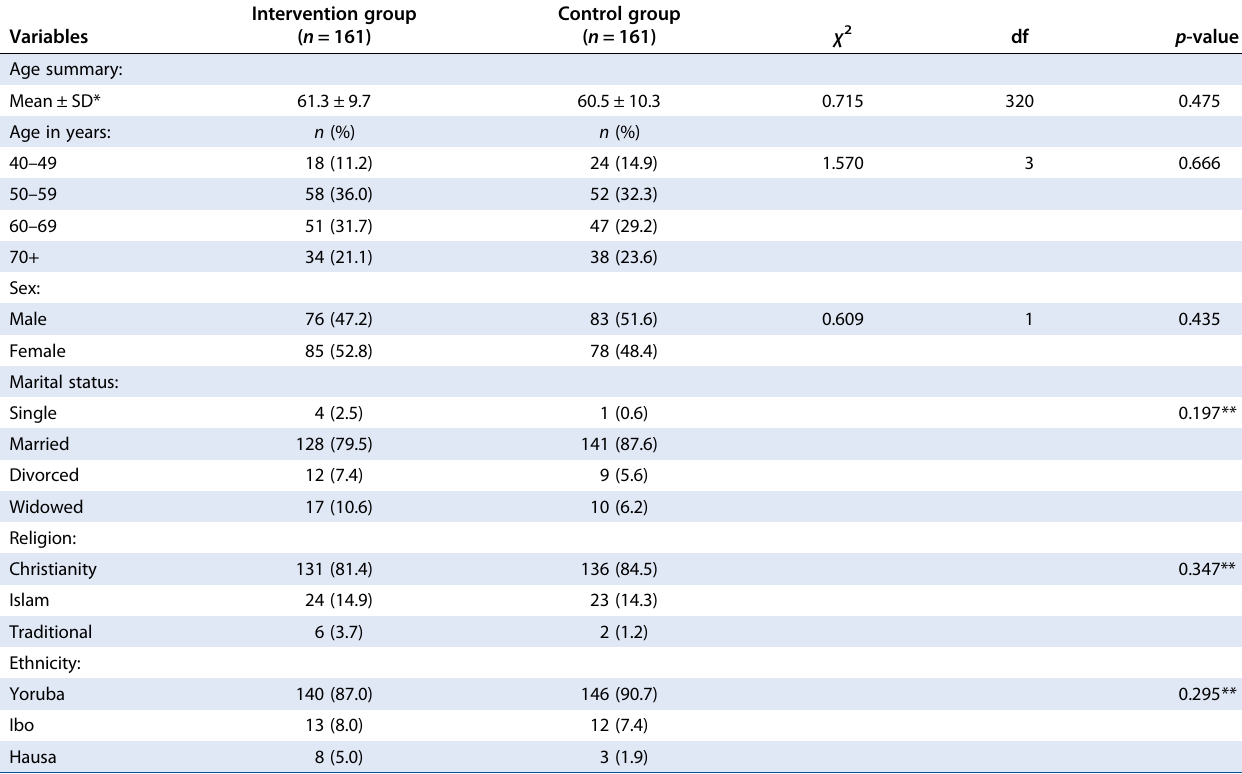
Table 1: Sociodemographic comparison of characteristics of respondents.